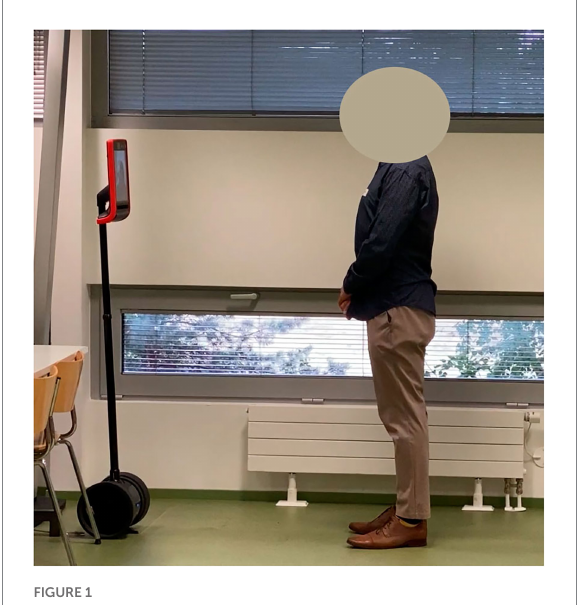
FIGURE 1 Example of a communication